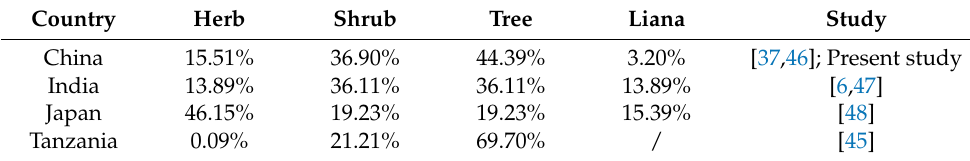
Table 1. Host plants’ life forms for Cassytha filiformis infestation in four countries. Country Herb Shrub Tree Liana Study China